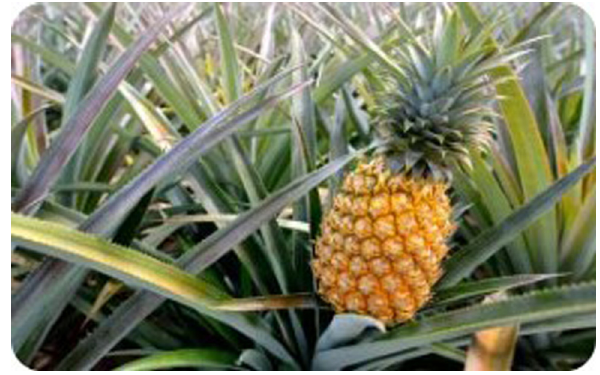
Figure 1: Photograph of Ananas comosus